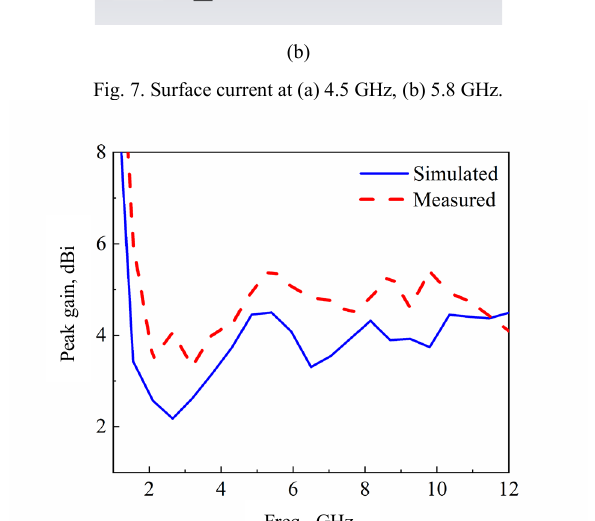
Fig. 5. Measured and simulated VSWR .